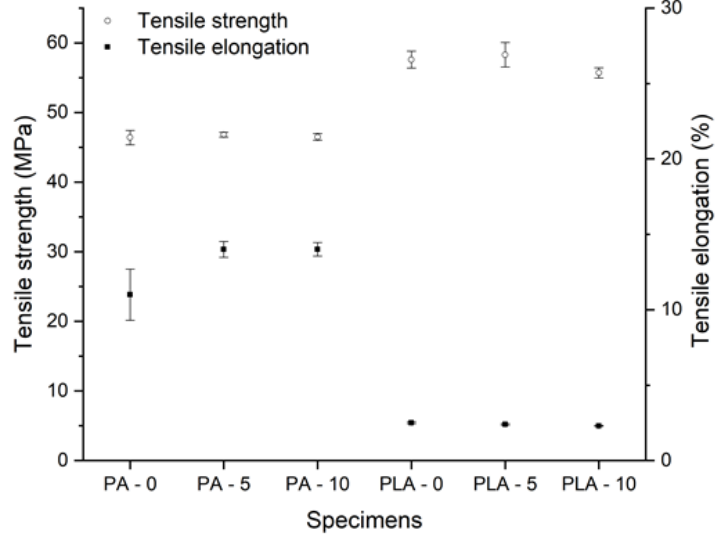
Figure 3. Results of tensile strength tests. The black squares indicate the means on tensile elongation (%) with the standard error, and the white dots show the mean values of tensile strength (MPa) with standard error. The test specimens are marked as: PA/PLA—0: Non-disinfected, PA/PLA—5: disinfected with 5 cycles, PA/PLA—10 disinfected with 10 cycles.